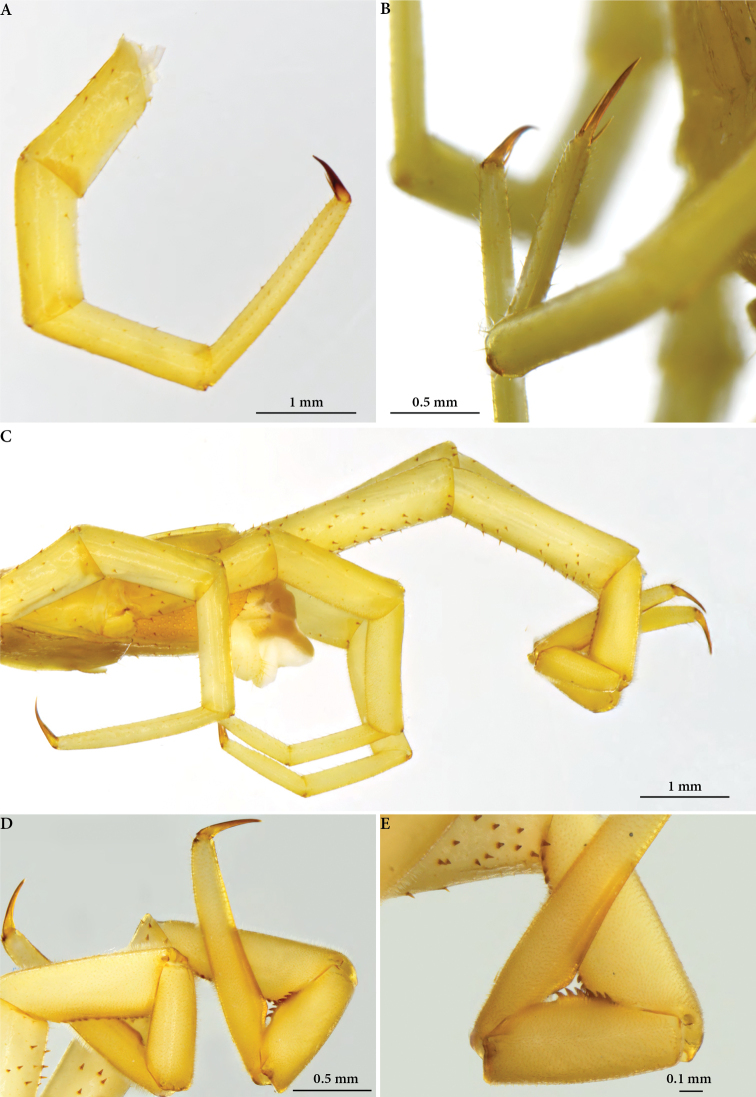
Cryptops
speleorex sp. nov., legs. A holotype, walking leg B paratype (ZMUT), walking leg, close-up of apical claw C holotype, ultimate legs, lateral view D, E paratype (NHMW), distal articles of ultimate teeth showing saw teeth.